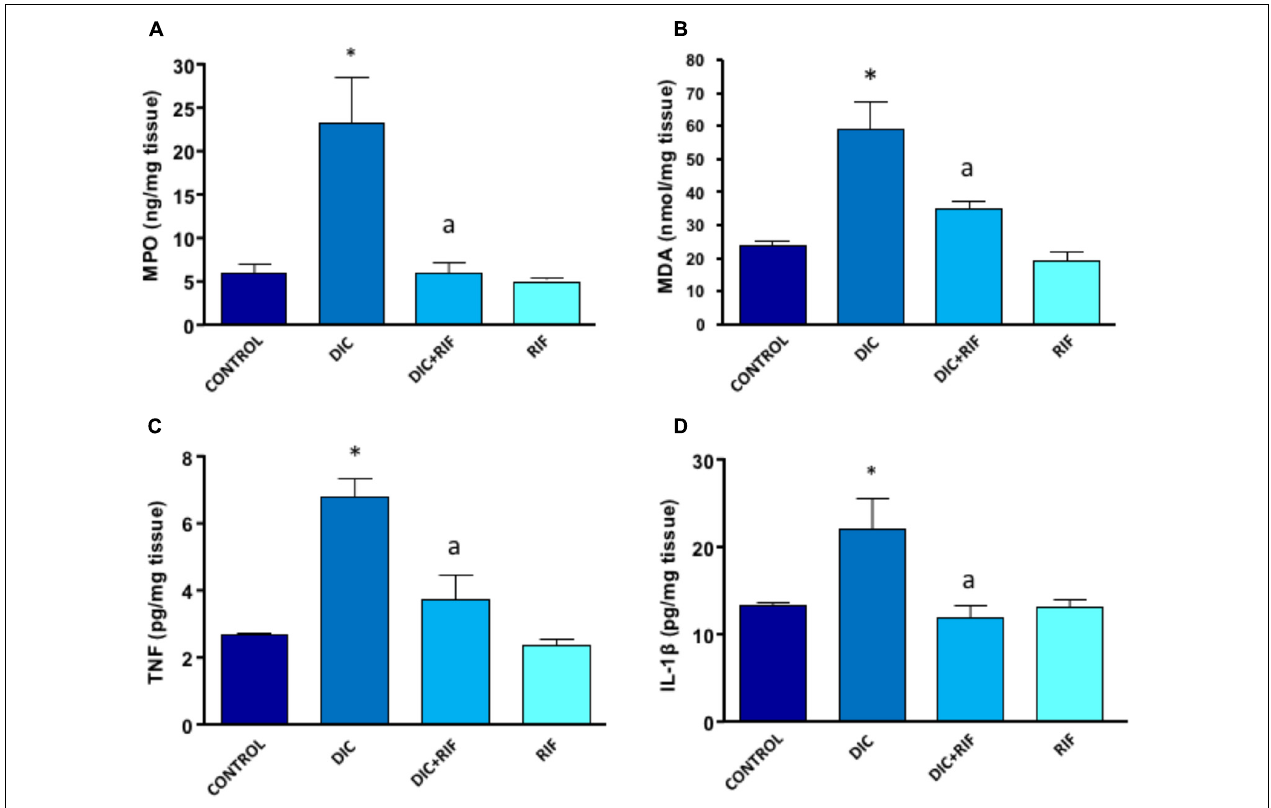
FIGURE 3 | Effects of vehicle (Control), diclofenac (DIC, 4 mg/kg BID), diclofenac plus rifaximin (DIC+RIF, 50 mg/kg BID), or rifaximin (RIF) for 14 days on myeloperoxidase (MPO) (A) , malondialdehyde (MDA) (B) , tumor necrosis factor (TNF) (C) , or interleukin-1 β (IL-1 β ) (D) in the ileum. Each column represents the mean ± SEM obtained from 10 animals. ∗ p < 0.05, significant difference versus Control; a p < 0.05, significant difference versus diclofenac